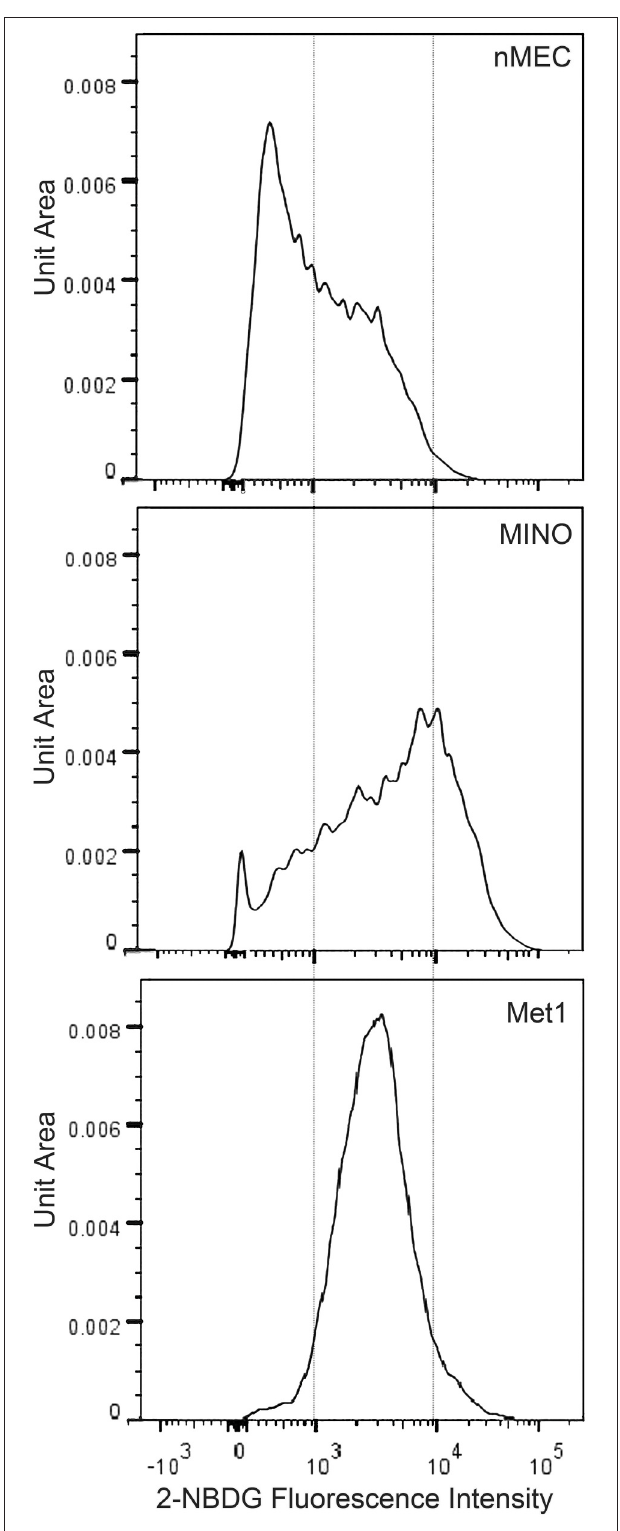
FIGURE 2 | Qualitative differences in glucose uptake in normal (nMEC),precancer(MINO)andcancer(MET1). Glucoseuptakepercellwas